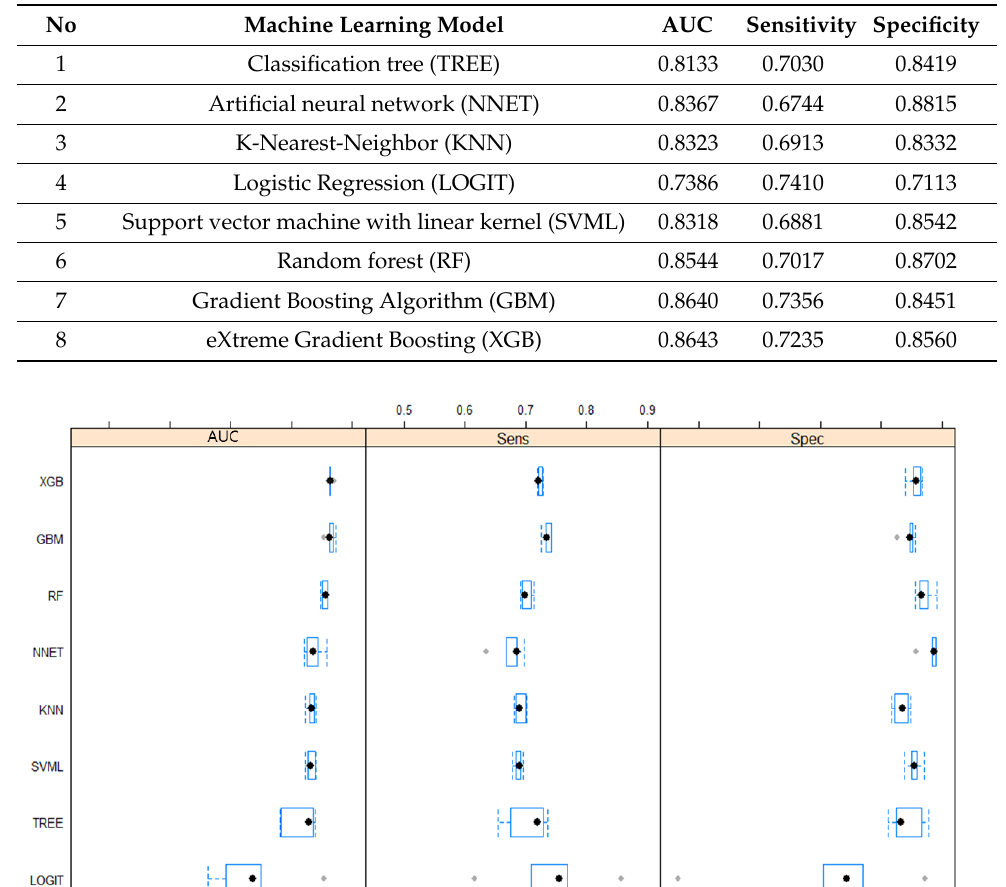
Table 5. Machine learning algorithm performance comparison.